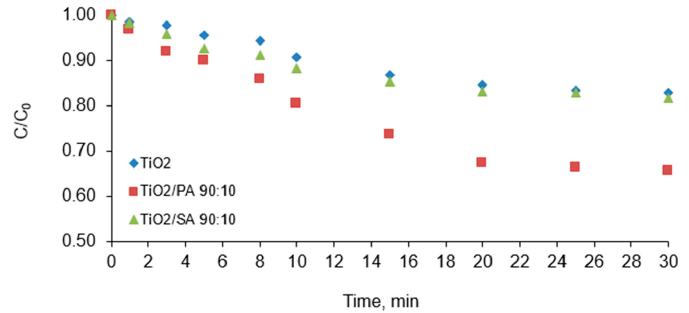
Figure 7. Effect of the contact time on the degree of chlorfenvinphos adsorption. Condition of = 1.0 mg / L; D = 50.0 mg / L; V = 500.0 mL; t = 30.0 min; pH = experiment: C 0 = 1.0 mg/L; D c = 50.0 mg/L; V r = 500.0 mL; t sor = 30.0 min; pH = 6.0. experiment: C c r sor 0